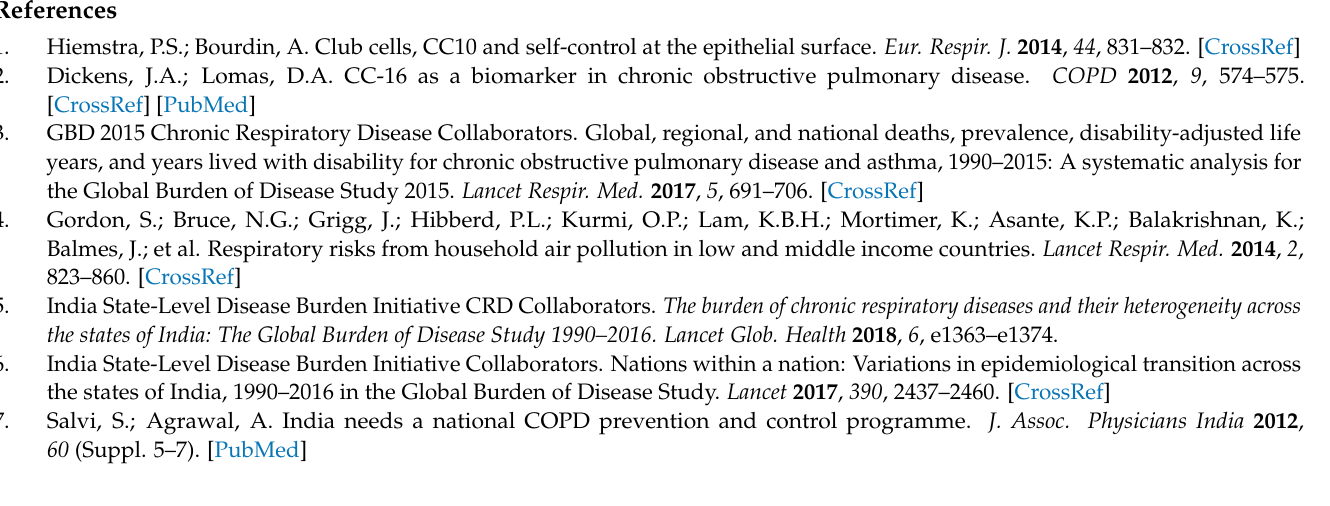
Table S2: Age based stratification analysis of serum secretoglobin family 1A member 1 (SCGB1A1) concentrations. Table S3: Correlation of serum concentrations of secretoglobin family 1A member 1 (SCGB1A1) with pre-and post-bronchodilator (pre-BD and post-BD) test of lung function. Table S4: Serum secretoglobin family 1A member 1 (SCGB1A1) concentrations in biomass smoke induced chronic obstructive pulmonary disease (BMS-COPD) subjects according to disease severity. Table S5: Transcript and secreted protein levels of secretoglobin family 1A member 1 (SCGB1A1) in